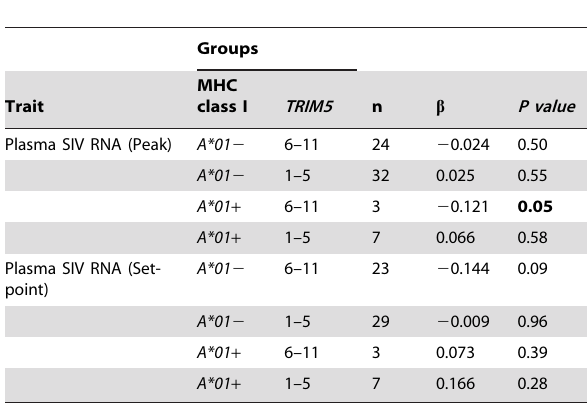
Table 3. Comparison of the regression coefficient ( b ) values and the significance of CCL3L copy number from rhesus monkeys expressing various combinations of both Mamu- A*01 and TRIM5